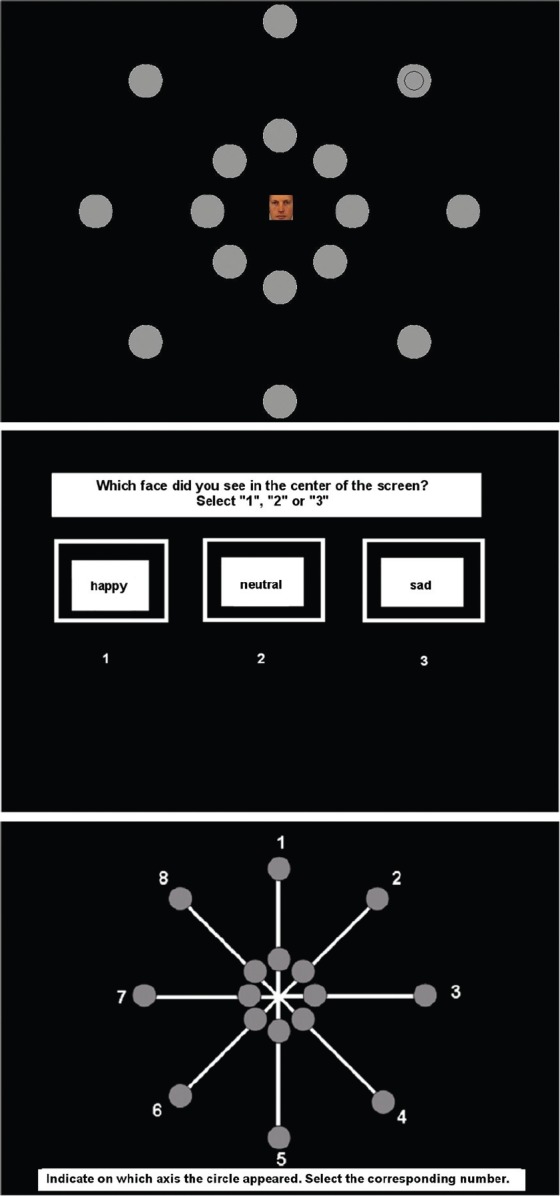
Stimulus presentation of the Attentional Breadth Task. The gray dots are presented in pairs of two, simultaneously with the central face and the target stimulus. The first response screen asks participants which face they have seen. The second response screen asks participants on which of eight axes the target stimulus was presented.